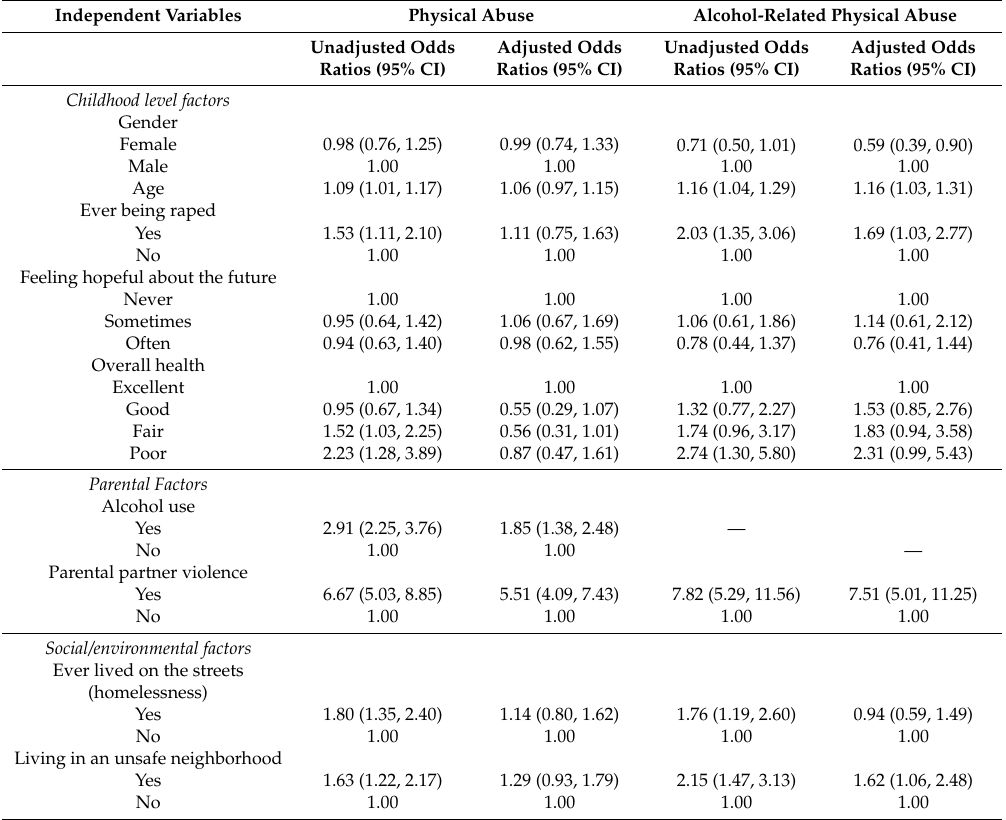
Table 3. Correlates of experiencing parental physical abuse and alcohol-related physical abuse among children living in the slums of Kampala, ( n =